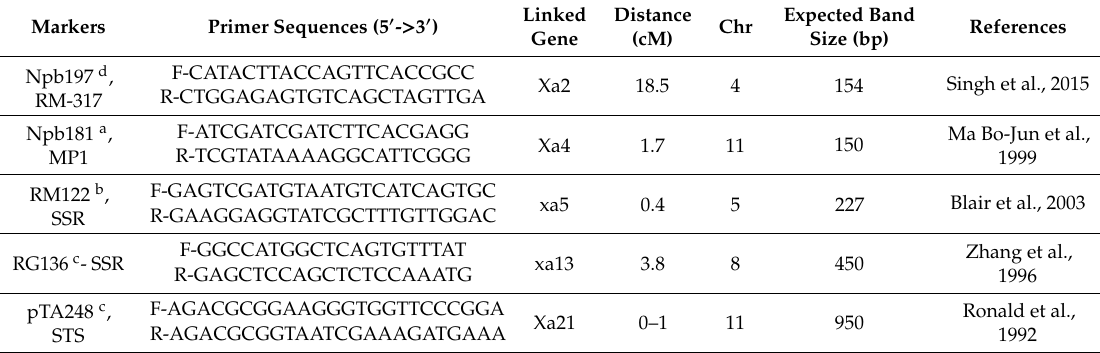
Table 1. Simple sequence repeat (SSR) and sequence tagged site (STS) markers for Xa resistance genes in